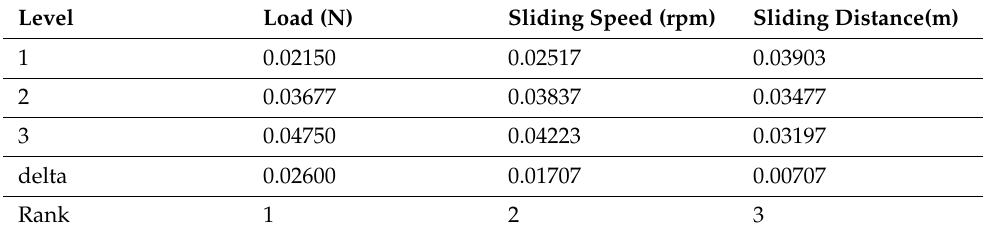
Table 11. Response Table for